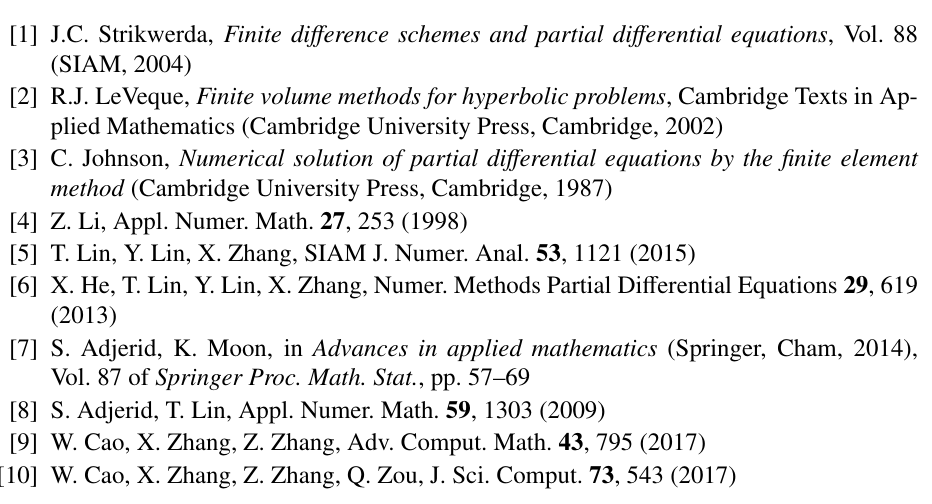
Table 3. Errors for Linear IFEM at final time for β + = 1 and β − = 100, ∆ t = h / 10